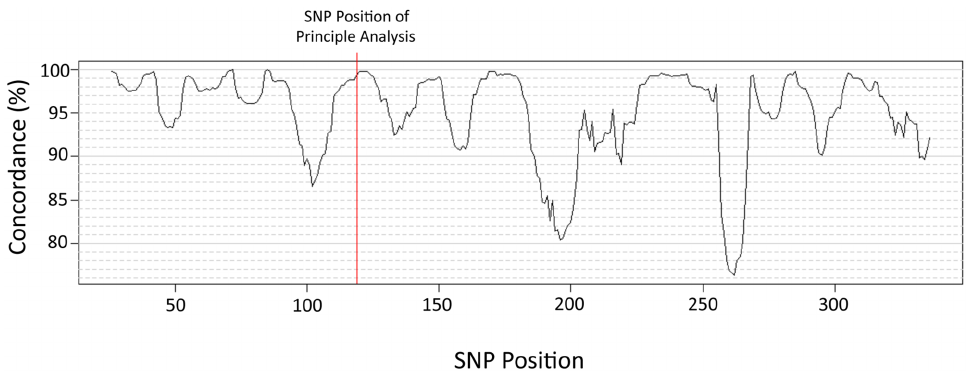
Figure 4. Concordance of the two SHAPEIT-2 analyses depending upon the SNP- position of the initial SNP used for the haplotype analysis. The first SHAPEIT-2 analysis predicted the complete haplotypes (across the entire region) starting at SNP-position 1. The second SHAPEIT-2 analysis predicted the complete haplotypes starting at SNP-position 25. The 11-tuple subject-vectors for the principle analysis undertaken here began at SNP-position 119 (rs2234167), as indicated by the verticle red